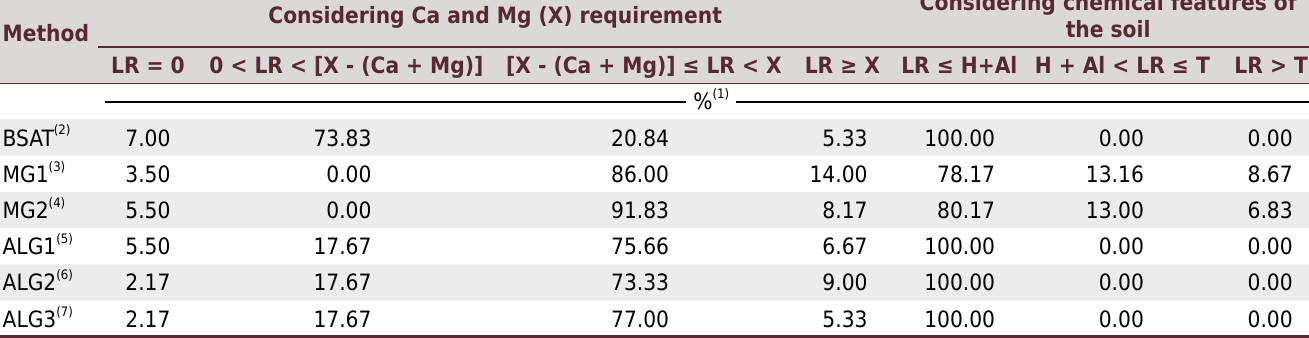
Table 5. Distribution frequency of liming requirements (LR) calculated by six different forms for 600 soil samples collected in coffee plantings, in regard to crop requirements and tolerance (V = 60 %, X = 3.5 and m t = 25 %), conditioned on coffee requirements in Ca 2+ and Mg 2+ (X) and the chemical properties of the soil (H+Al and